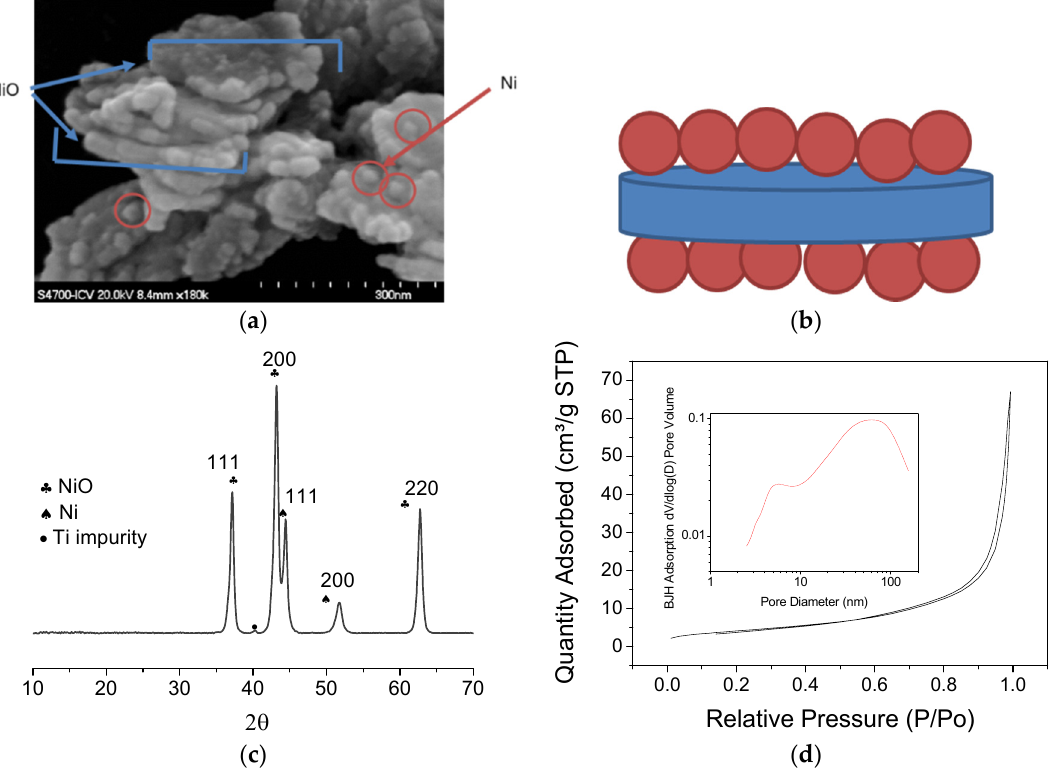
Figure 2. ( a ) FESEM images of the NiO ‐ Ni powders; ( b ) scheme of the arrangement of NiO ‐ Ni core ‐ shell nanoparticles; ( c ) XRD patterns of the NiO ‐ Ni powders after the synthesis process; and ( d ) N 2 gas adsorption ‐ desorption isotherms and pore size distribution of as ‐ prepared NiO ‐ Ni nanostructure.